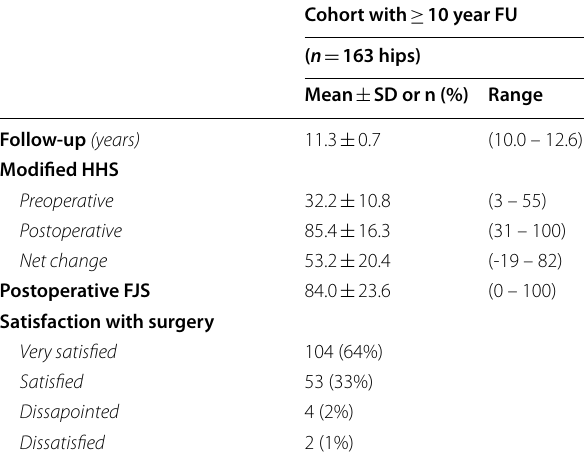
Table 2 Clinical scores and satisfaction with surgery